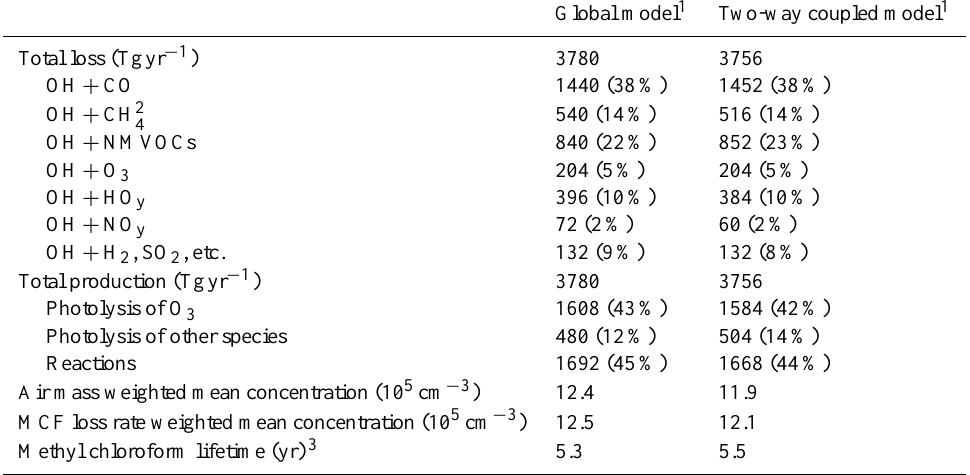
Table 4. Global budget of tropospheric OH for